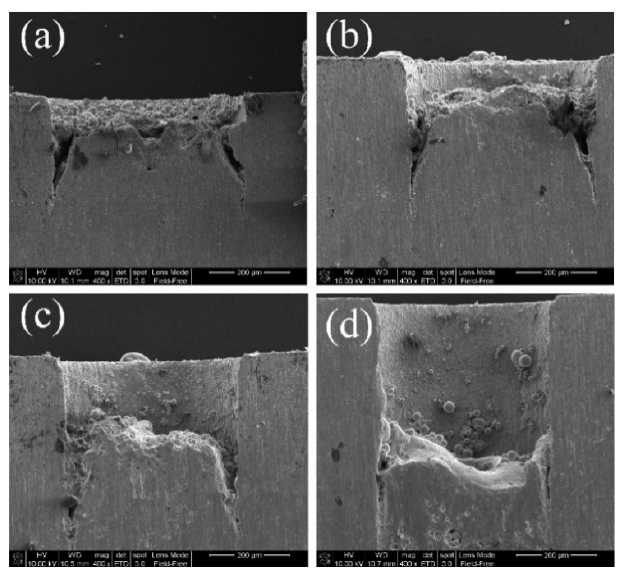
Figure 5. Tapers of the inverted cone under different feeding layers: ( a ) 2, ( b ) 4, ( c ) 10, and ( d ) 50. Table 2. Scanning parameters of femtosecond-laser with di ff erent